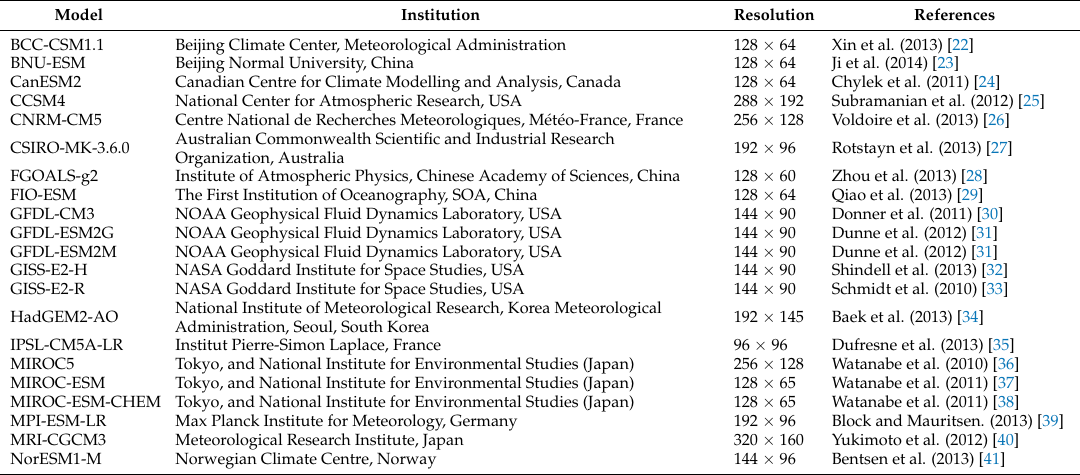
Table 3. Summary of 21 general circulation models from coupled model inter-comparison project phase 5